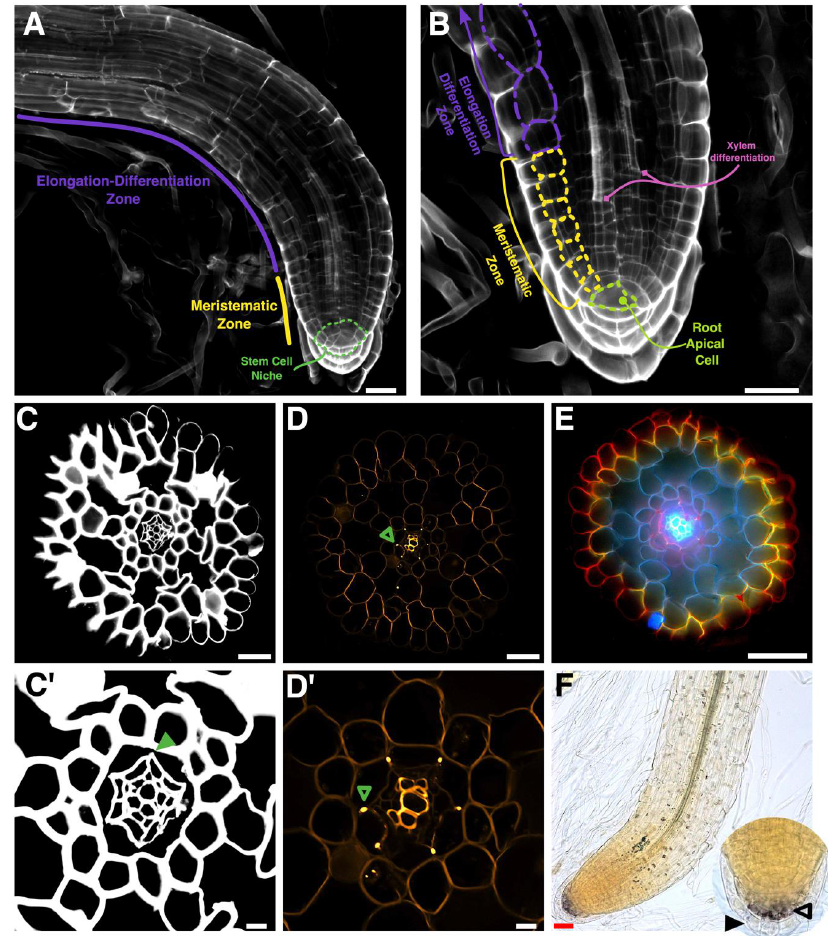
Figure 4. Histological analyses of the Ceratopteris richardii first stem-borne root. ( A ) Whole root stained with Calcofluor White with the established zonation. ( B ) The RAM in 30 daf Ceratopteris sporelings has a prominent tetrahedral apical cell. The cell length changes between MZ and EDZ after the meristem boundary. The meristematic zone ends when cells begin to elongate. The change in cell elongation can be detected by measuring length of the outer cortex layer. The xylem cells begin to differentiate before leaving the meristematic zone. The Ceratopteris first stem-borne root meristem has an average size of is seven cells. ( C , C’ ) Transverse section of a root, stained with Calcofluor White to detect cell walls and observed with CLSM. Endodermal cell walls did not stain (green arrowhead). ( D , D’ ) Transverse section of a root stained with berberine and aniline blue. Vasculature and endodermis positions were assigned due to the fluorescent signals in the xylem cell walls and the Casparian strip, respectively (green unfilled arrowhead). ( E ) Transverse section of a root stained with berberine, lactic acid, and safranin, observed in an epifluorescence microscope. ( F ) Amyloplasts detection using lugol staining in the root. (Inset) A strong signal is detected in the middle layer of the root cap (black-empty arrowhead) but not in the outer layer (black-filled arrowhead). Scale bar: 50 µ m ( A – F ); 10 µ m ( C (cid:48) , D (cid:48)